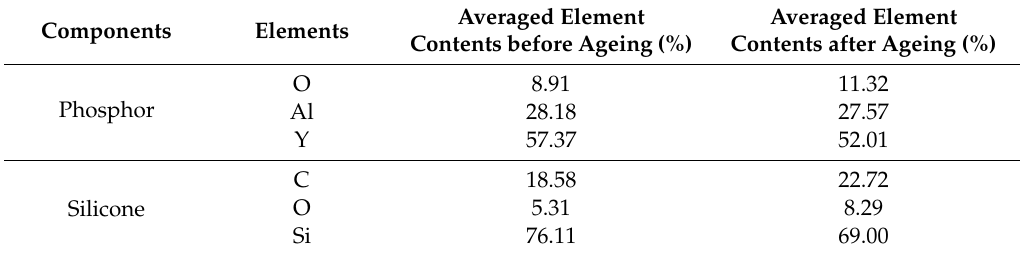
Scheme 3. Cross-linking reaction of silicone under high moisture conditions. Table 3. Comparison of chemical element content before and after ageing.